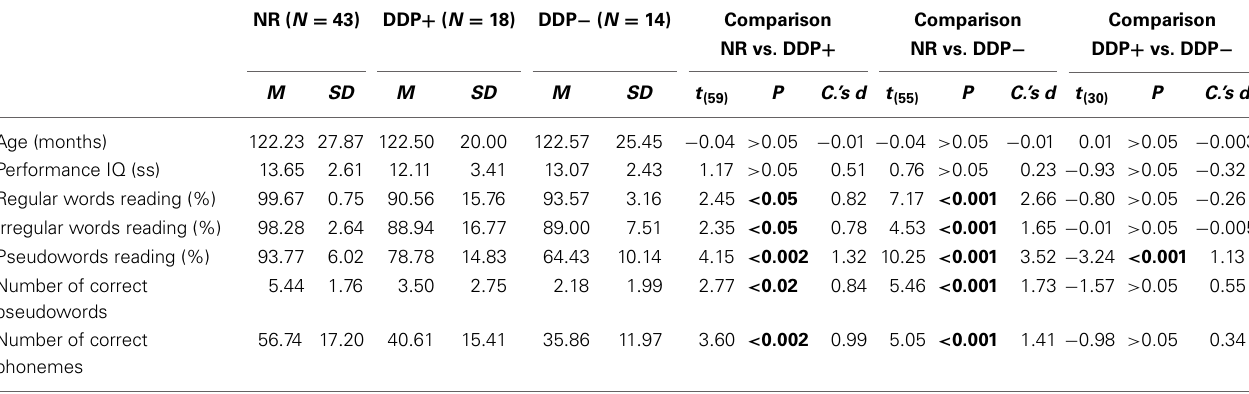
Table 1 | Mean (M) and standard deviation (SD) of age (months), Performance IQ (Figure Completion, Wechsler, 1993), Reading abilities (Regular, Irregular words, and Pseudowords), pseudowords phoneme blending (number of correct pseudowords), and a pseudoword short-term memory (number of correct phonemes) in normally reading children (NR) and developmental dyslexics without (DDP + ) and with (DDP − ) phonological decoding